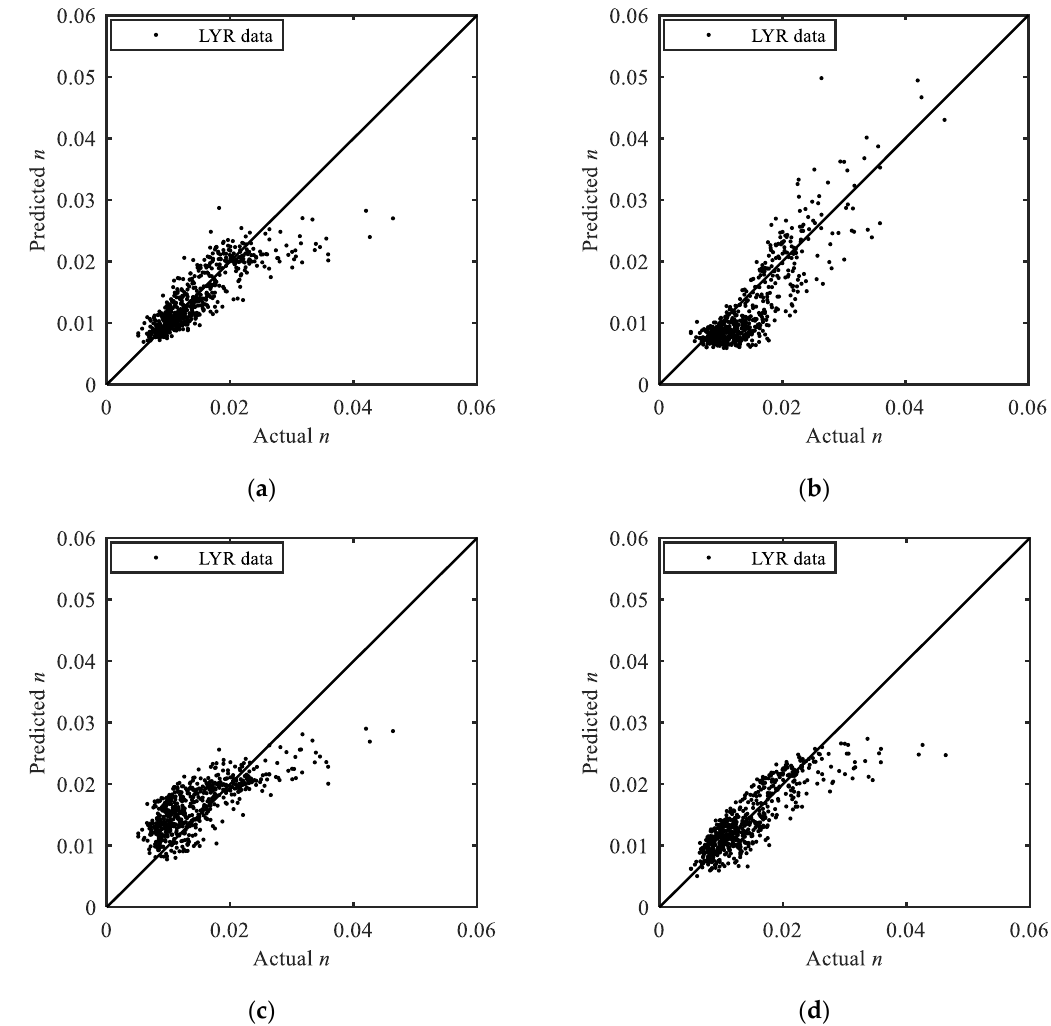
Figure 4. Predicted n plotted against actual n with the LYR validation data: ( a ) The proposed Equation (11); ( b ) Zhao-Zhang equation; ( c ) Wu-Wang equation; ( d ) Ma-Xia equation. Table 4. Performance of di ff erent flow resistance equations with the LYR validation data. The Condition